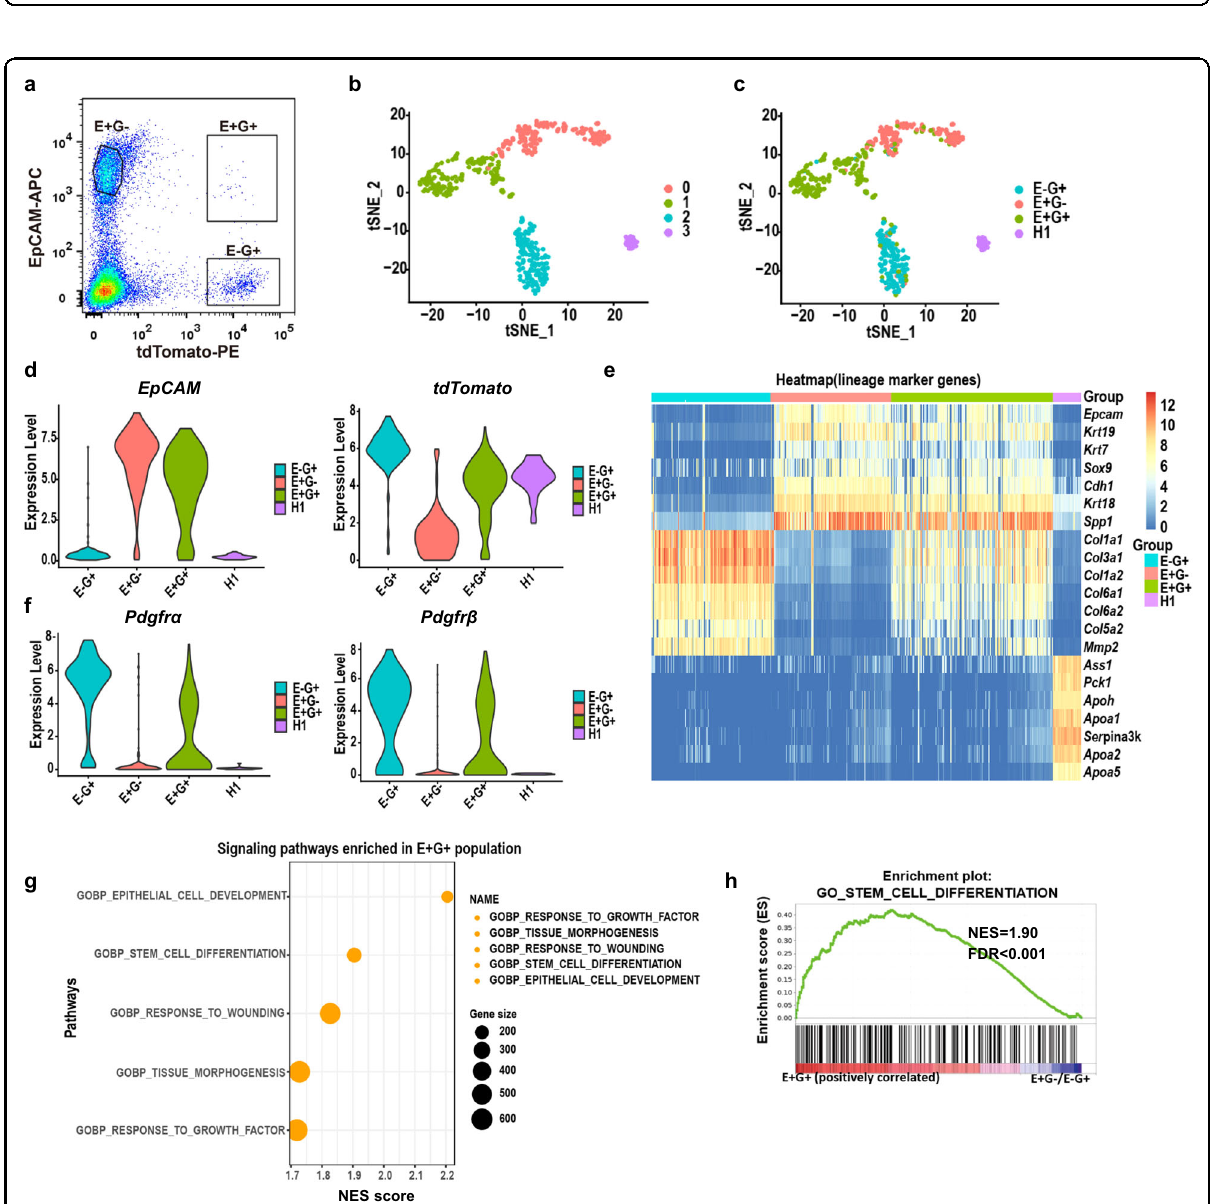
Fig. 4 Single-cell transcriptome analysis identi fi es cell lineages expressing EpCAM and Gli1. a Representative pro fi les of FACS-sorted EpCAM + Gli1 − , EpCAM − Gli1 + and EpCAM + Gli1 + cell populations from Gli1-Cre ERt2 ;Ai9 mice for scRNA-seq. b , c t-stochastic neighbor embedding (tSNE) plot of 527 individual cells isolated in a (dots). d Violin plots showing expression of EpCAM and tdTomato as determined by scRNA-seq. E + G − EpCAM + Gli1 − , E − G + EpCAM − Gli1 + , E + G + EpCAM + Gli1 + , H1 hepatocyte. e Heatmap of scRNA-seq data showing enriched genes in the 4 different clusters. f Violin plots showing expression of selected speci fi c lineage-associated genes as determined by scRNA-seq. g GO annotation of EpCAM + Gli1 + cells. h Signaling pathways that were signi fi cantly enriched in EpCAM + Gli1 + cells were identi fi ed using BioCarta gene sets for GSEA. P < 0.05. E + G − EpCAM + Gli1 − , E − G + EpCAM − Gli1 + , E + G + EpCAM + Gli1 + , H1 hepatocyte.